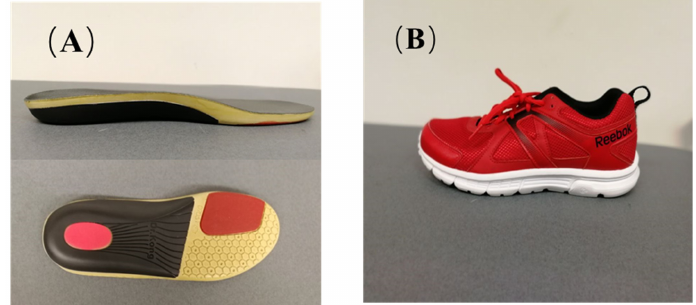
Figure 2. The view of foot insole ( A ) and shoe ( B ).